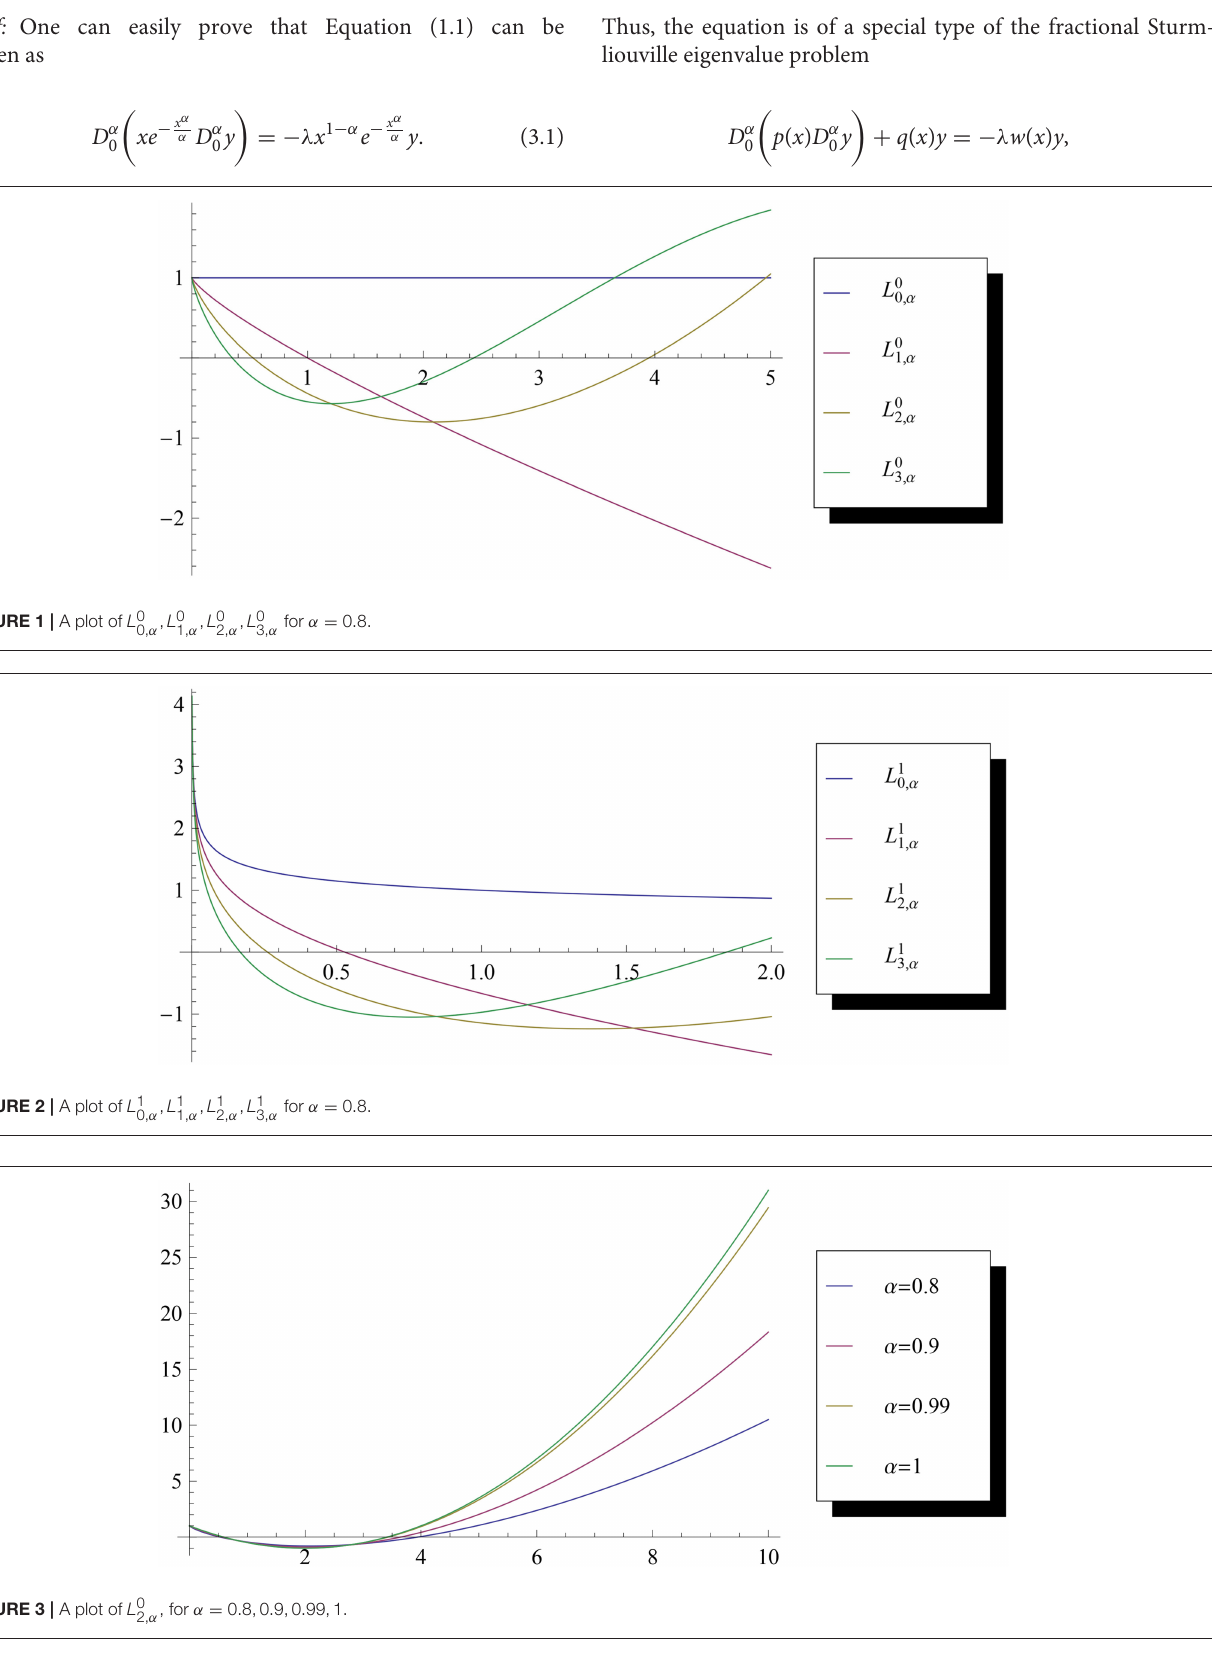
Frontiers in Applied Mathematics and Statistics |